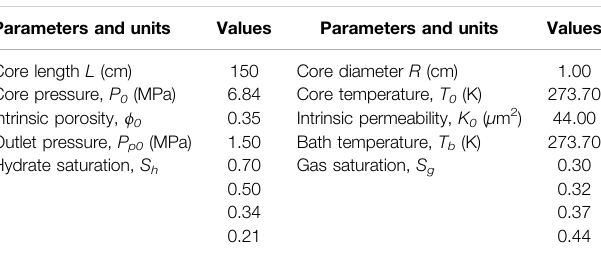
TABLE 3 | The parameters and data used in the numerical simulation. Parameters and